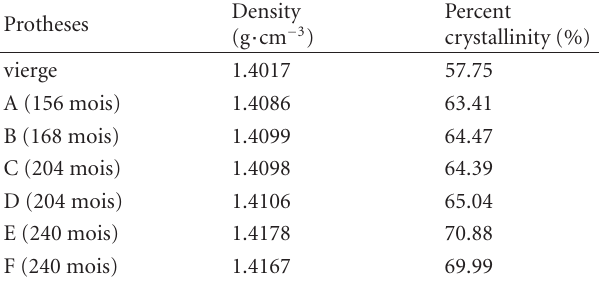
Table 3: Density and the percent crystallinity value of